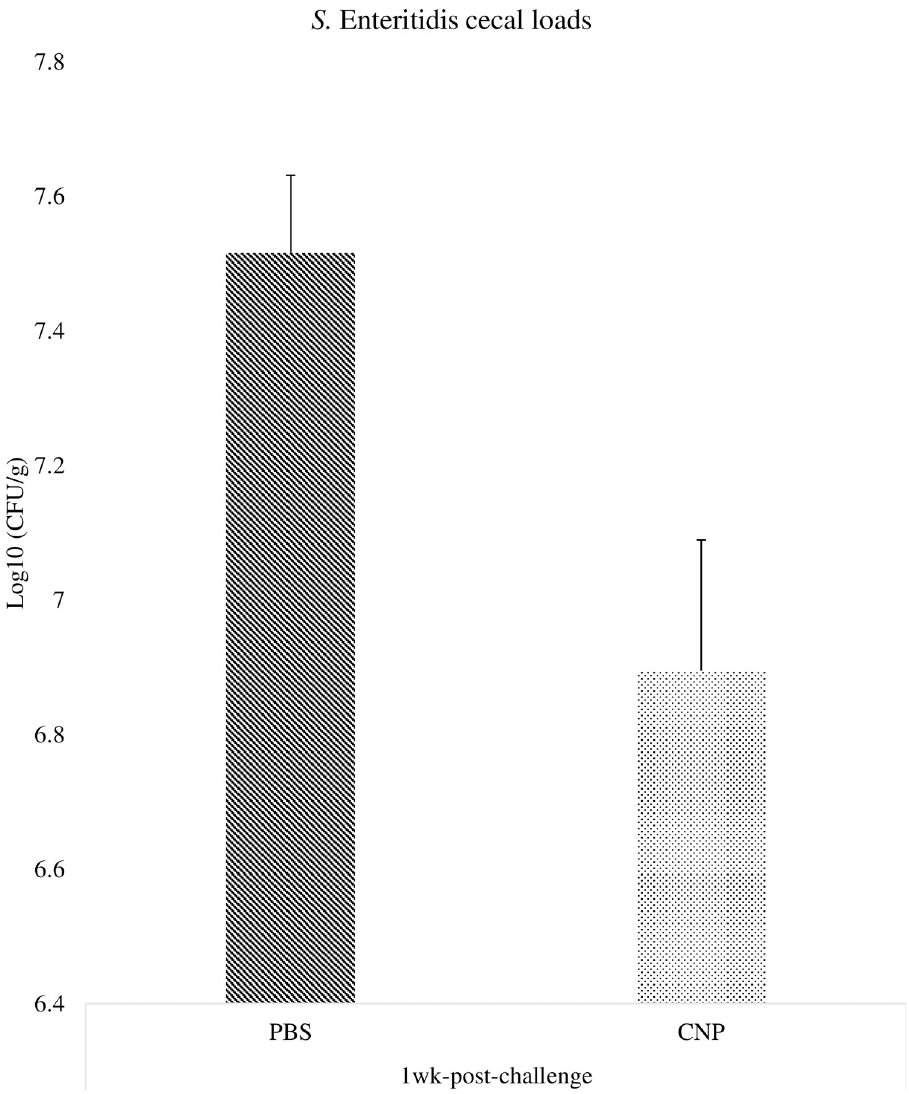
Fig 4. Salmonella loads in the ceca of chickens vaccinated in-ovo with CNP at 1wk-post-challenge. At embryonic d18, broilers egg were vaccinated with either PBS (control) or 1000 μ g CNP vaccine. At d7 of age, birds were challenged with live SE (1.0 × 10 9 CFU/bird). Ceca samples were collected from 3 birds/pen, pulled, and stomached for enumeration by plating on XLT-4 agar. Salmonella enumeration data were recorded as CFU/g of ceca and then transformed to Log 10 CFU/g of ceca for statistical analysis. Data analyzed by parametric Student t-test; Means+SEM. Bars. n = 6. " � " means P < 0.05.